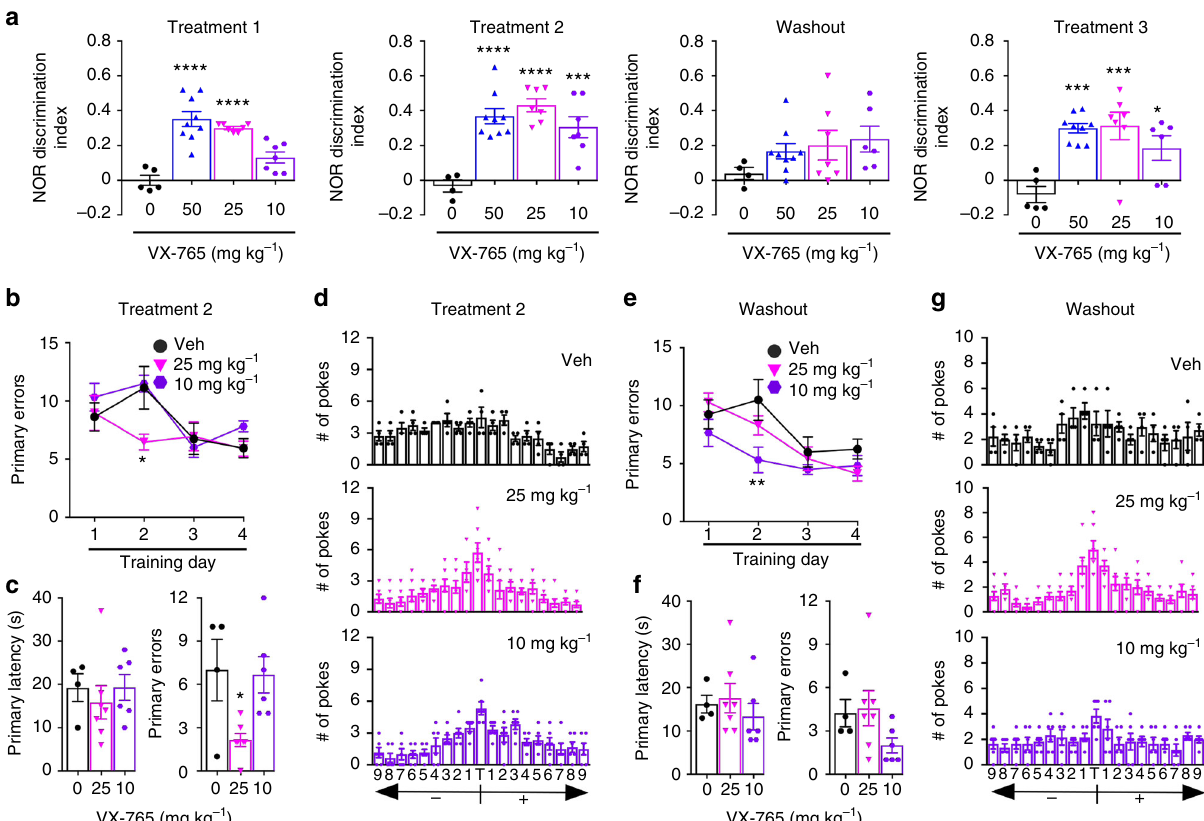
Fig. 2 VX-765 dose-dependently restores cognitive function in J20 mice. a NOR discrimination index at T1 (F(3,24) = 20.42, p < 0.0001), T2 (F(3,23) = 12.83, p < 0.0001), WO, and T3 (F(3,23) = 8.828, p = 0.0004). Vehicle-treated (black circles), and 50 mg kg − 1 (blue triangles), 25 mg kg − 1 (pink triangles), or 10 mg kg − 1 (purple hexagon) VX-765-treated J20 mice. Each mouse tested is represented by one symbol. Data represent mean and s.e.m. b − g Barnes maze during b − d T2 and e − g WO. Learning acquisition at b T2 and e WO; probe and target preference at c , d T2 and f , g WO. Learning acquisition # of primary errors during b T2 (Treatment, F(2,56) = 3.377, p = 0.0412; Training day, F(3,56) = 7.102, p = 0.0004), and e WO (Treatment, F (2,56) = 5.434, p = 0.007; Training day, F(3,56) = 11.52, p < 0.0001), probe primary errors at c T2 (F(2,14) = 5.69, p = 0.0155). a , c , f ANOVA and b , e Two-way repeated-measures ANOVA, Dunnett ’ s post-hoc versus J20 + vehicle, * p < 0.05, ** p < 0.01, *** p < 0.001, **** p <